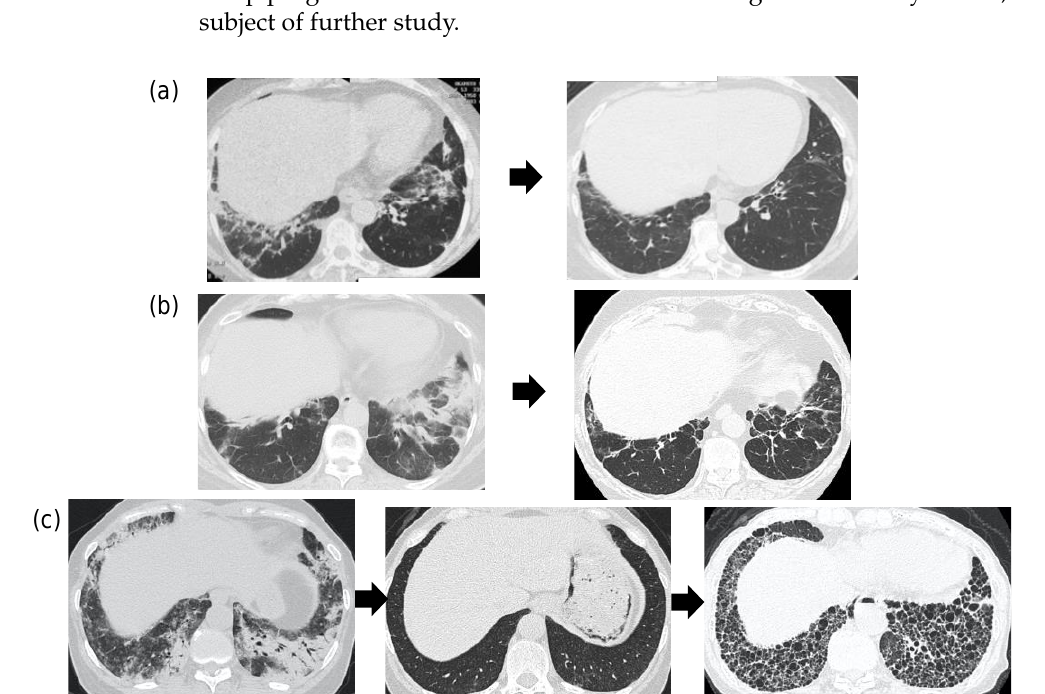
Figure 2. CT findings of anti-ARS antibody-positive ILD. ( a ) Prednisolone was administered, dense shadows along the bronchial vascular bundles improved, and prednisolone was discontinued after about 10 years. ( b ) Prednisolone and tacrolimus treatment left mild fibrosis after 4 years. ( c ) Prednisolone and cyclosporine A treatment achieved temporary improvement after 4 months, but fibrosis worsened after about 13 years.